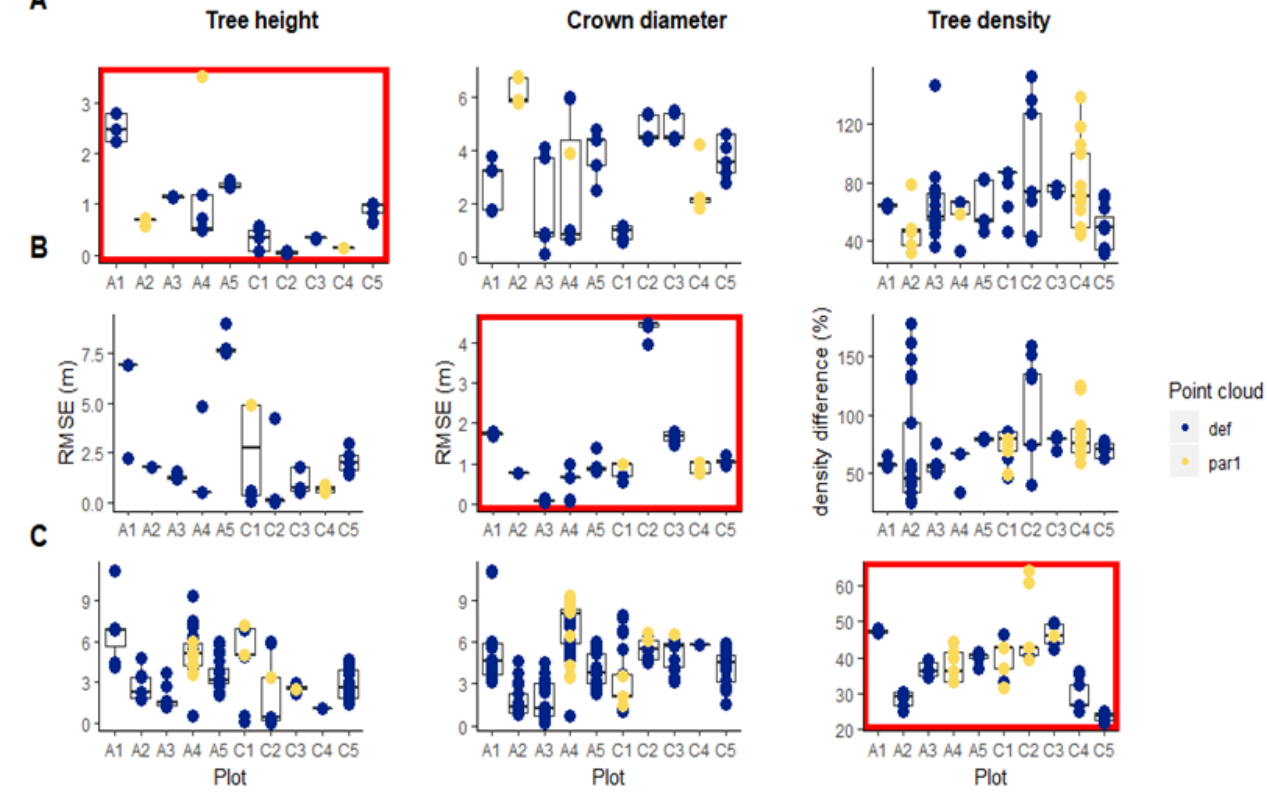
Figure 5. Model performance for tree height, crown diameter, and tree density. ( A ) Models were selected based on the lowest RMSE for tree height; ( B ) models selected based on the lowest RMSE for crown diameter; and ( C ) models selected for lowest difference in tree density.